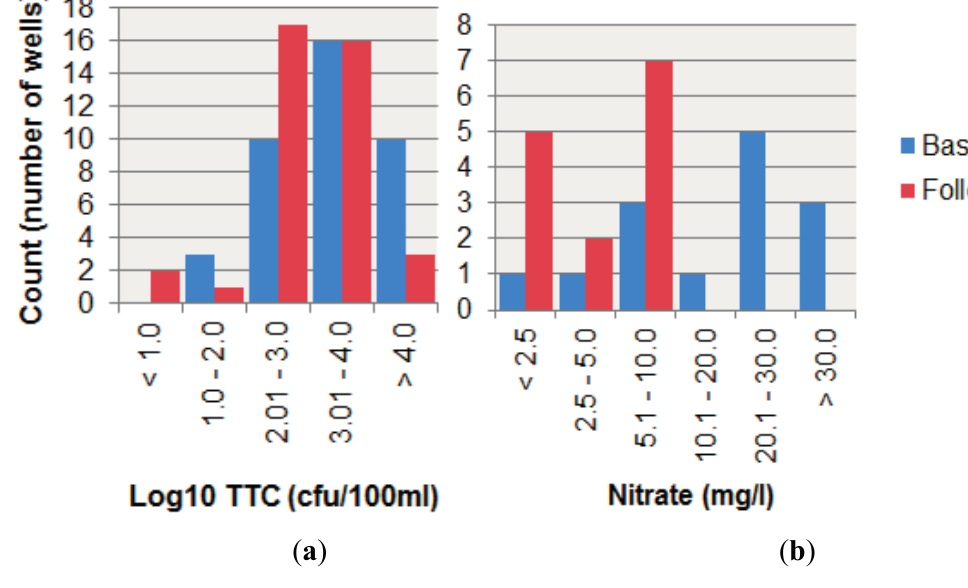
Figure 5. Comparison of water quality for pairs of wells tested in both baseline (1998–2004) and follow-up surveys (2014) for ( a ) thermotolerant coliforms (n = 39); ( b ) nitrate (n =